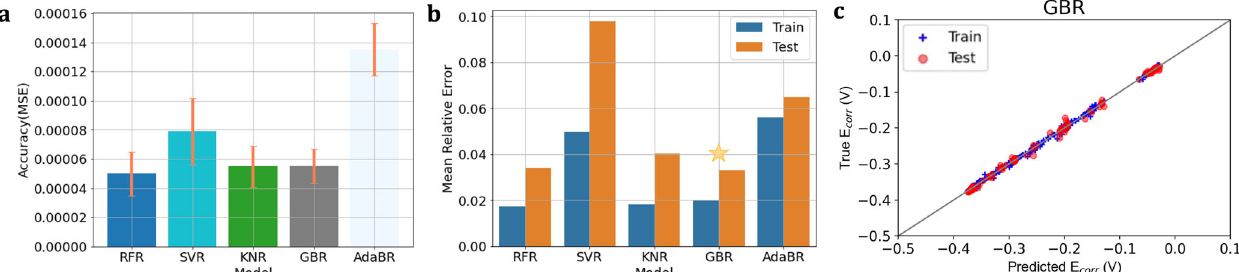
Fig. 3 Evaluation for traditional machine learning models. Parameter tuning and model selection of the traditional machine learning models: a The mean squared errors with variances (error bars) of the parameter tuning process for RFR, SVR, KNR, GBR, and AdaBR; b The mean relative errors of machine learning models on the training set and testing set separately; c Diagonal scatter plot of the ground truth versus the predicted E corr by GBR during training and testing, respectively. Ecorr free corrosion potential, SVR support vector regression, KNR k-nearest neighbor regression, GBR gradient boosting regression, RFR random forest regression, AdaBR AdaBoost regression.